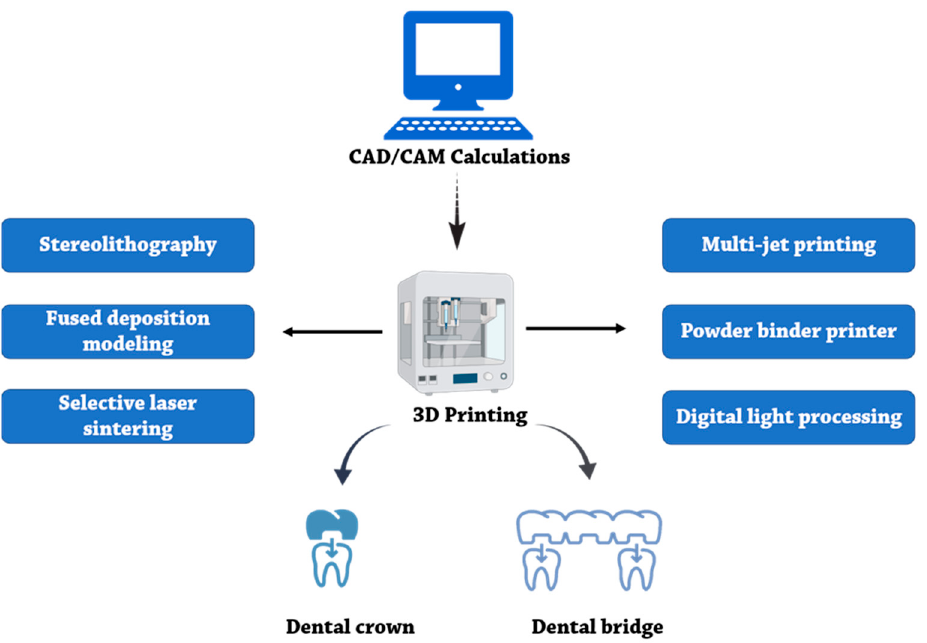
Figure 1. Different 3D-printing models for fabricating dental crowns and bridges.